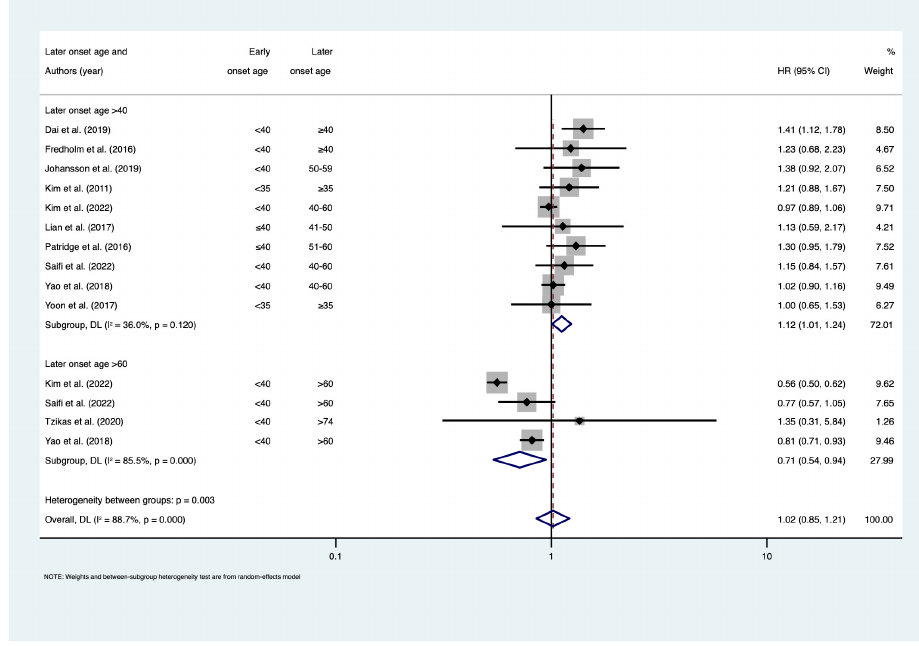
Figure 4. Forest plot for meta-analysis of breast cancer-specific survival. Hazard ratios less than 1 show favourable outcomes in early-onset age group; hazard ratios greater than 1 show poorer outcomes in early-onset age group. References [13,22,25,27,29,30,33,40,42,48,49]. Abbrevia- tions: CI = confidence interval; HR = hazard ratio.